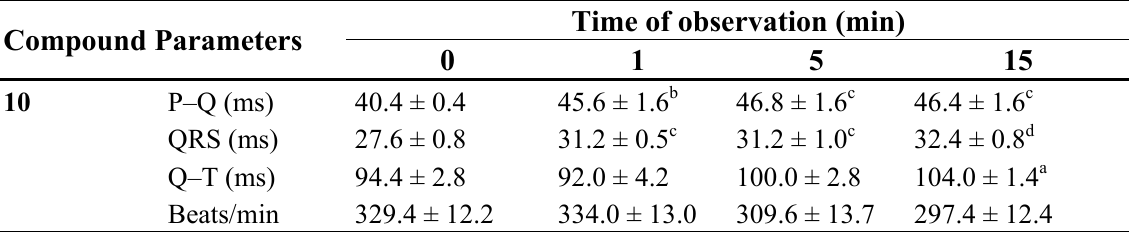
Table 2. Effects of an iv injection of the investigated compounds in dose of 1 mg·kg -1 on heart rate and ECG intervals in anesthetized male Wistar rats (60 mg of thiopental·kg -1 , ip